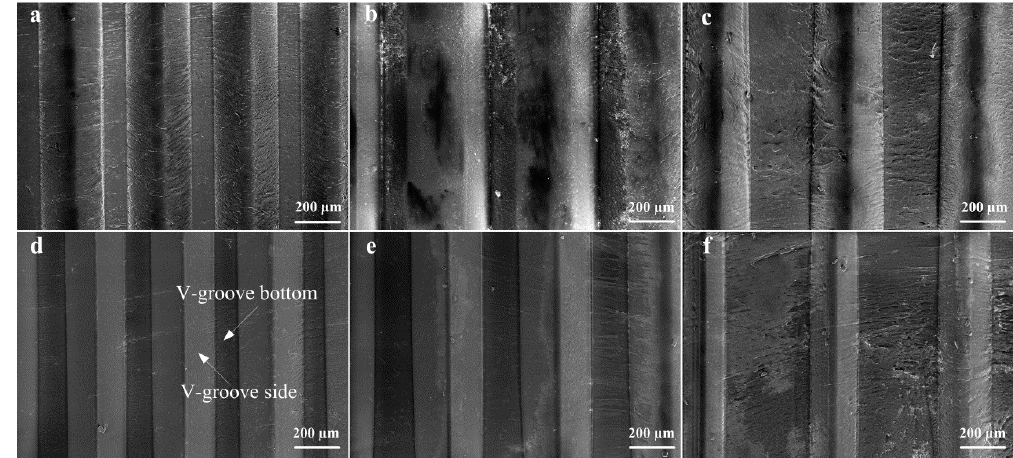
Figure 7. SEM photos of micro-structured polymers: (a) Sample A w ; (b) Sample B w ; (c) Sample C w ; (d) Sample D w ; (e) Sample E w ; (f) Sample F w .